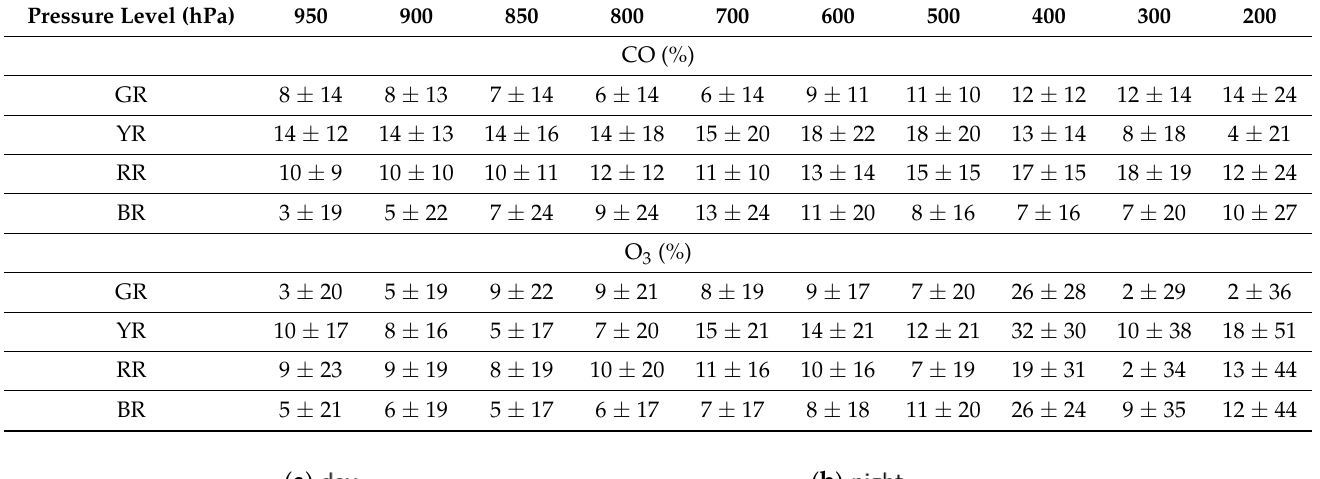
Table A1. Mean values and std of the relative change of CO and O 3 as they were calculated per region and pressure level of the study area.